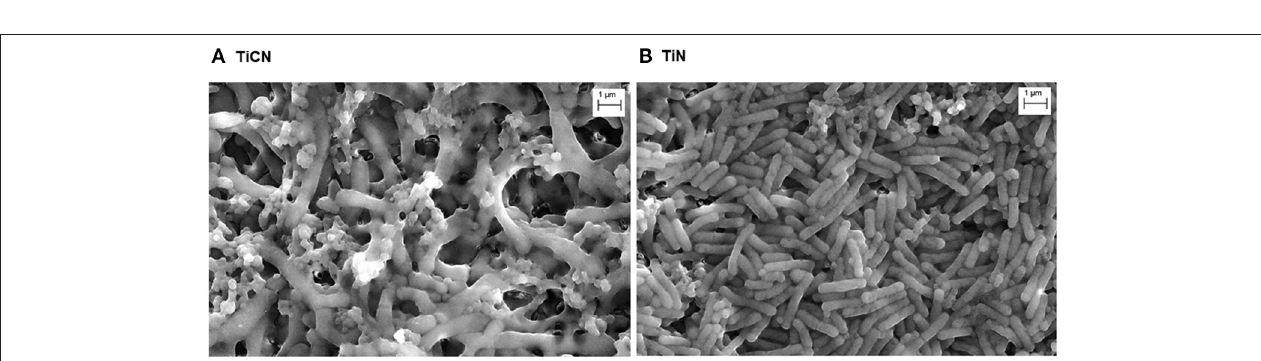
FIGURE 4 | Visualization of oral microbial biofilms formed on (A) TiCN and (B) TiN coatings via scanning electron microscopy (SEM) after 7 days of biofilm growth in 50% SHI medium with Scr and Man.